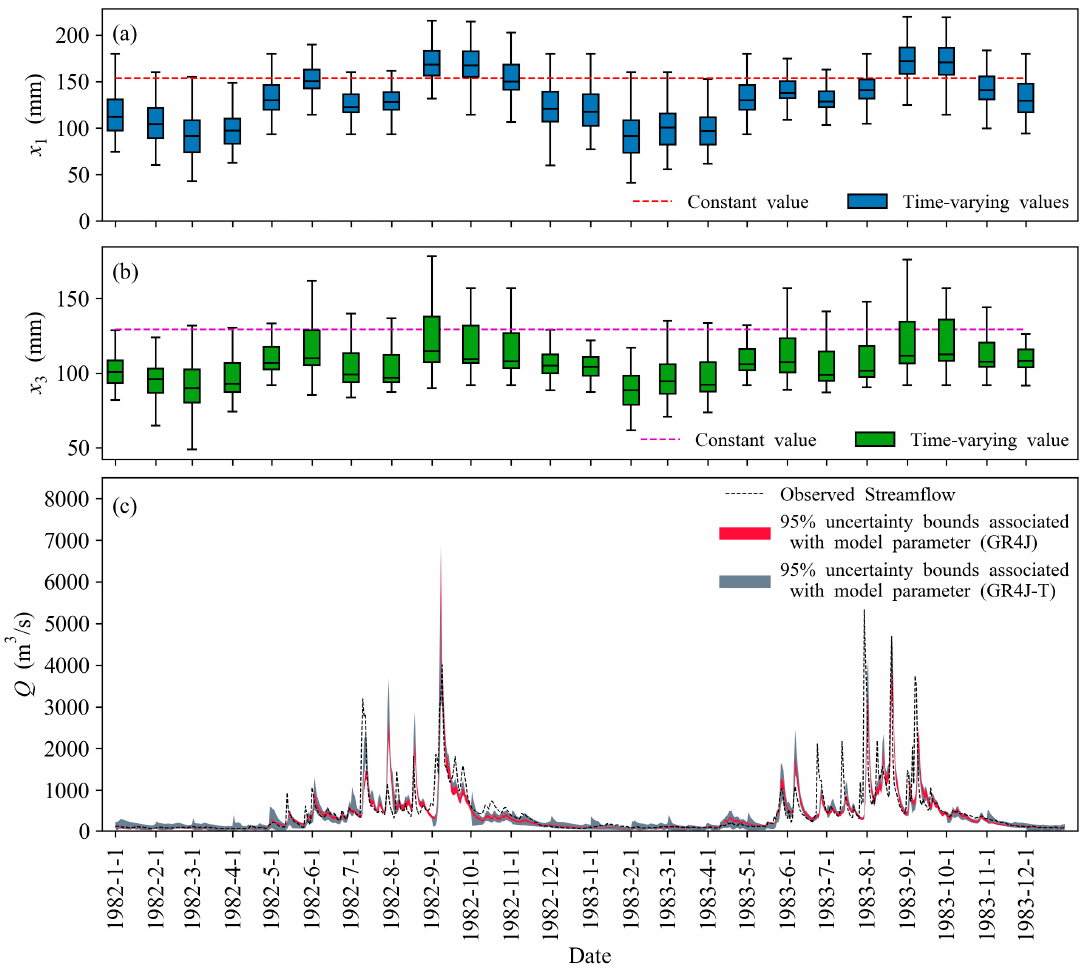
Figure 7. Temporal comparison of the values of the parameter ( a ) x 1 and ( b ) x 3 , and ( c ) the simulated daily streamflow of the GR4J model and the GR4J-T model for Tuojiang Basin during SP1 (only the period from 1 January 1982 to 31 December 1983 are presented here). The uncertainty bounds associated with model parameter are derived from the streamflow simulation results using the corresponding 5000 parameter sets.